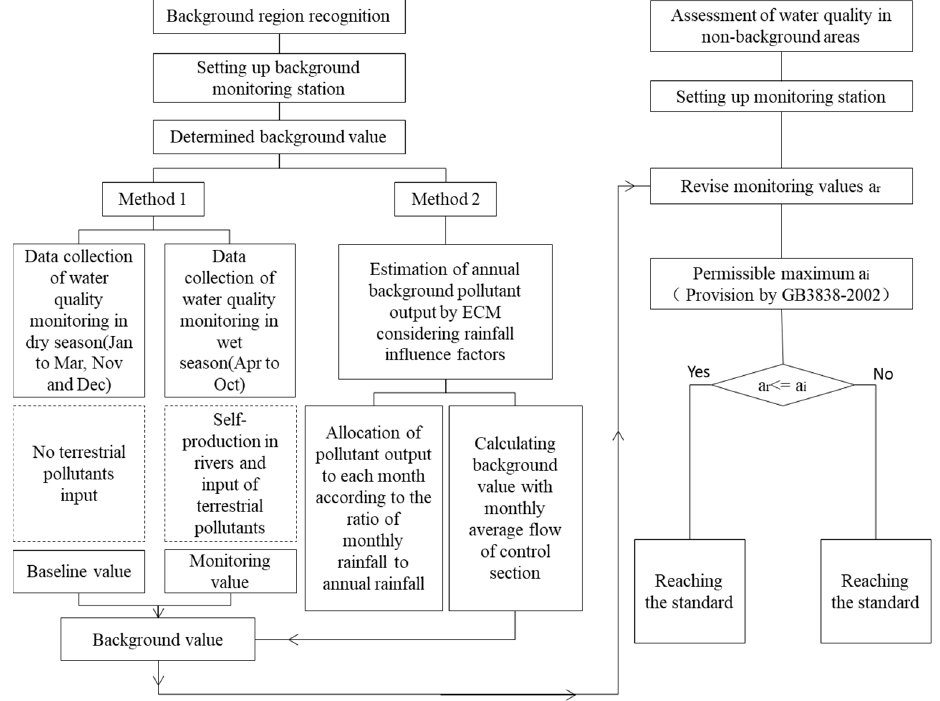
Figure 10. Flow chart of assessment methods considering background value.